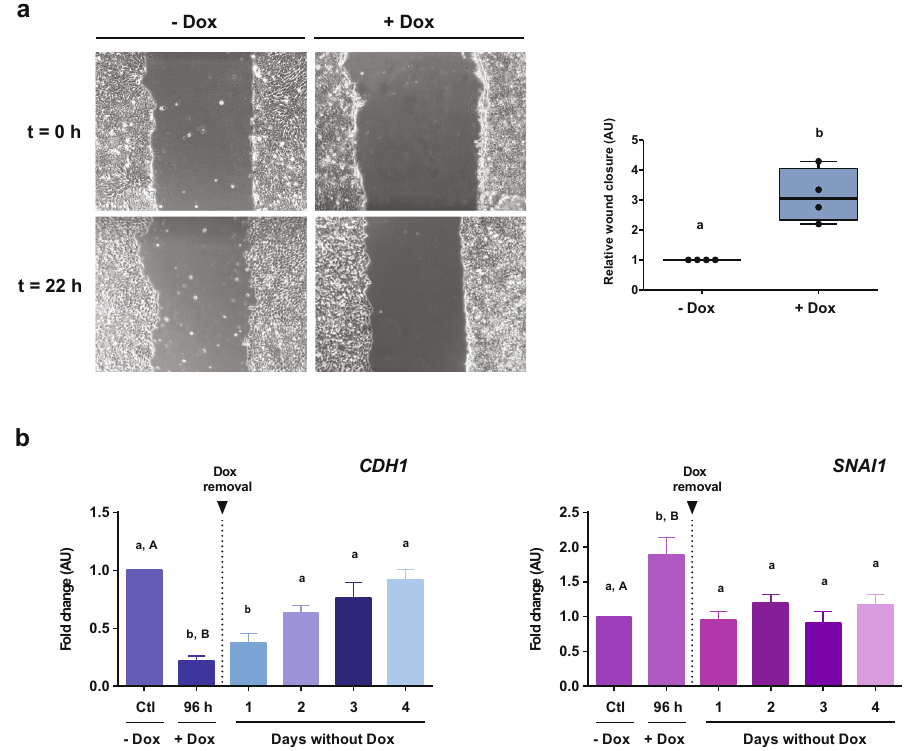
Figure 5. Silencing of E-cadherin induced a partial EMT state. ( a ) Wound healing assay was made after cells were treated with or without Dox (+Dox and −Dox, respectively) (t = 0 h). Cells were treated with Dox during 72 h and then scratch was made (t = 0 h for this experiment). Images were taken at t = 0 h and after 22 h of recovery (t = 22 h) (left). Graphic represents the relative wound closure area of at least four independent experiments (right). AU is the abbreviation for arbitrary units. T test. Different letters indicate significant differences. ( b ) Rescue experiment to regain the knockdown effect. Cells were incubated with Dox for 96 h. At this time point, Dox was removed and cells were maintained for another 96 h (4 days) only with culture medium. CDH1 and SNAI1 gene expression was evaluated by qPCR. Results are represented as mean ± SD (n = 5). AU is the abbreviation for arbitrary units. ANOVA with post hoc Tukey. Different letters indicate significant differences of groups compared to control condition (p <